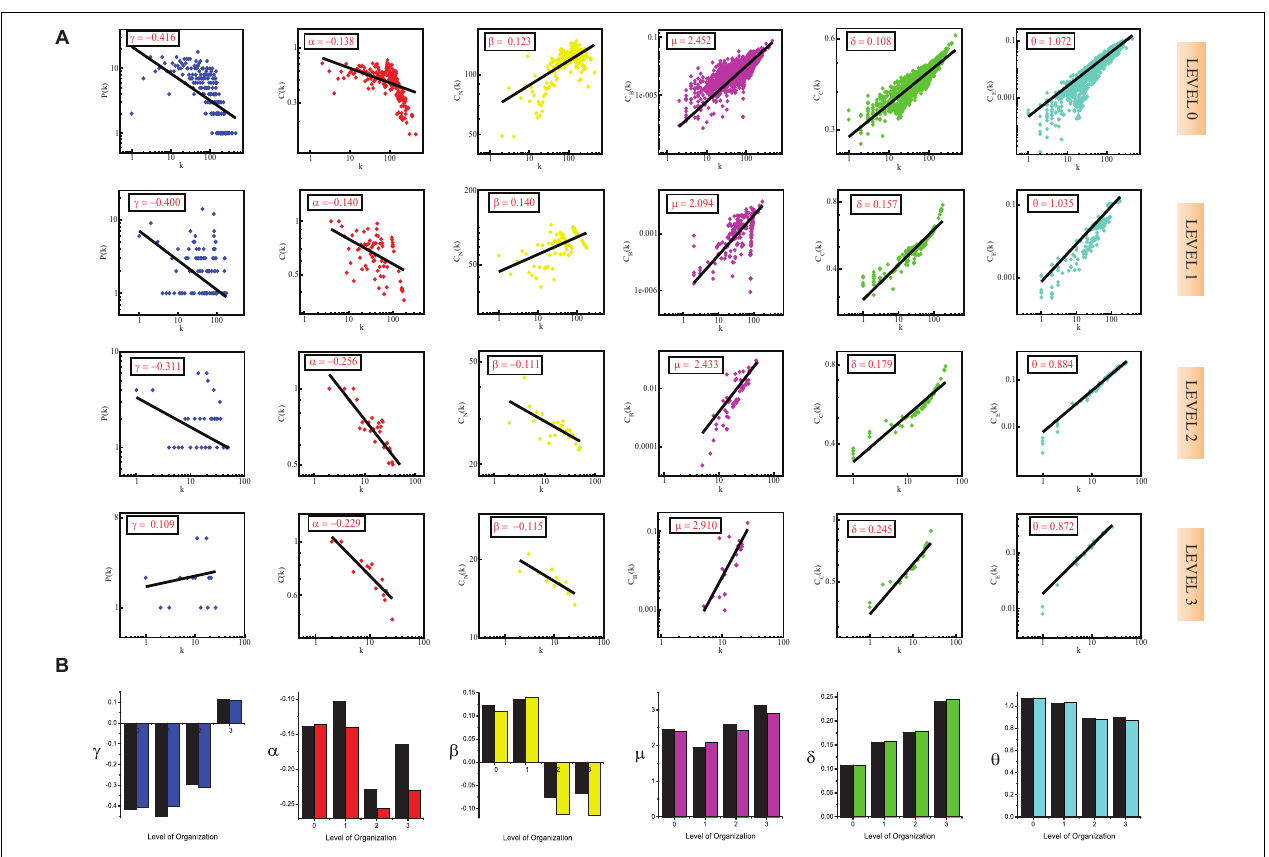
FIGURE 2 | (A) showing probability of degree distribution P ( k ), clustering coefficient C ( k ), neighborhood connectivity C N ( k ), betweenness centrality C B ( k ), closeness centrality C C ( k ), and eigenvector centrality C E ( k ) as a function of degree ( k ) for primary original network (level 0) and TNRC6B motif knockout networks at different levels of the organization (level 1–3). (B) showing changes in the values of the topological properties’ exponents of the TNRC6B motif knockout networks [colors corresponding to the ones used in the topological properties plots i.e., blue for P ( k ), red for C ( k ), yellow for C N ( k ), magenta for C B ( k ), green for C C ( k ), and turquoise for C E ( k )] compared with the topological properties’ exponents of the corresponding original networks (black) at different levels of the organization. γ , α , β , µ , δ , and O are the exponents of the degree distribution, clustering coefficient, neighborhood connectivity, betweenness centrality, closeness centrality, and eigenvector centrality,